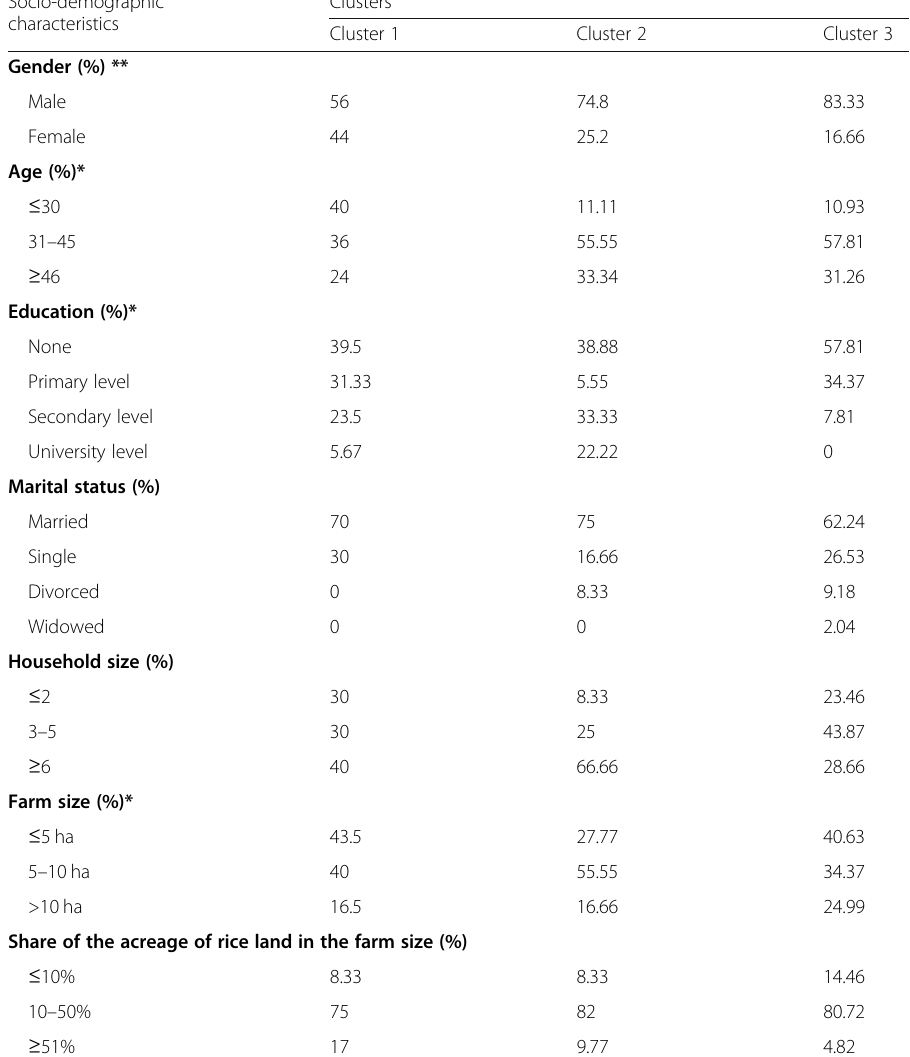
Table 5 Socio-demographic characteristics of rice farmers across the clusters Socio-demographic characteristics